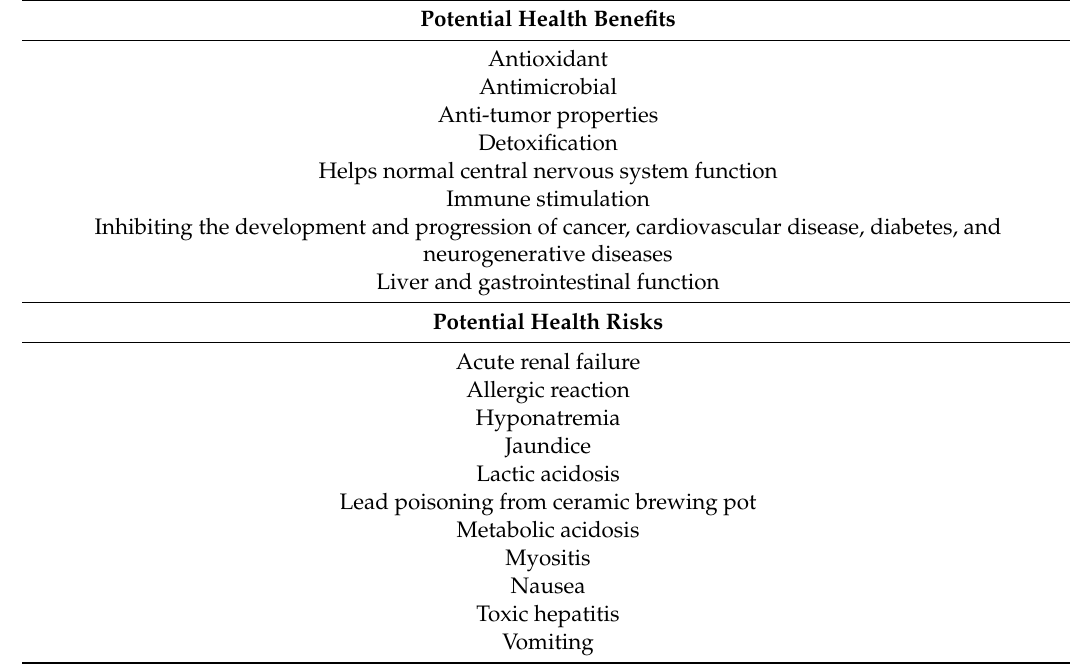
Table 3. Example of potential health benefits and health risks of kombucha consumption